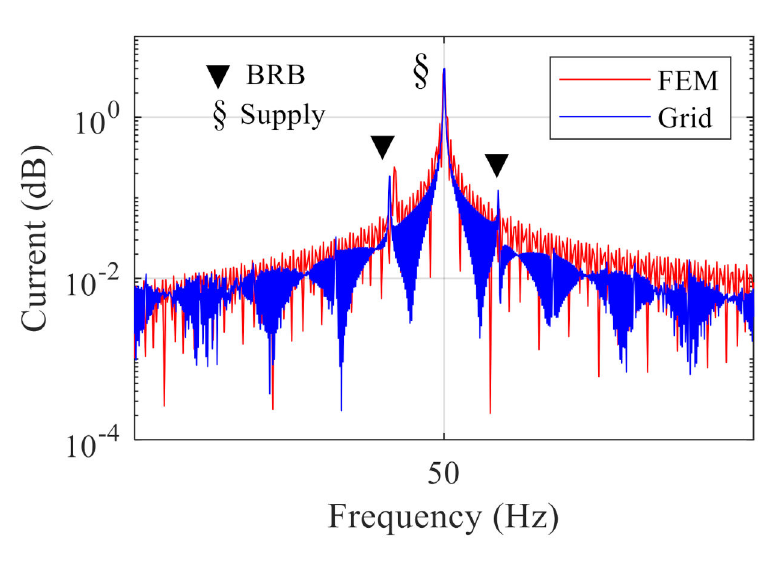
Figure 9. The broken rotor bars-based side-band